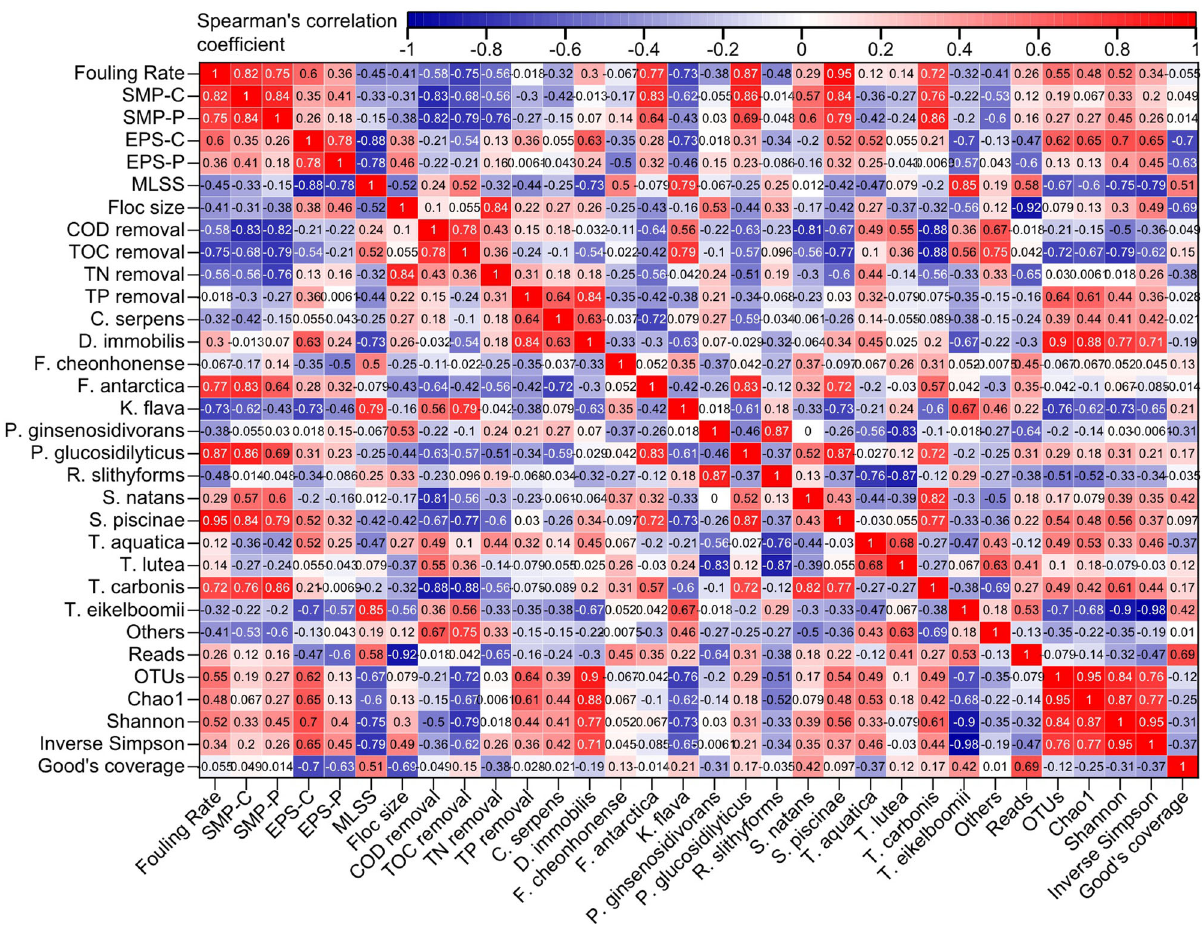
Fig. 4 Correlation analysis. Spearman ’ s correlation coef fi cients between all the MBR parameters determined in the